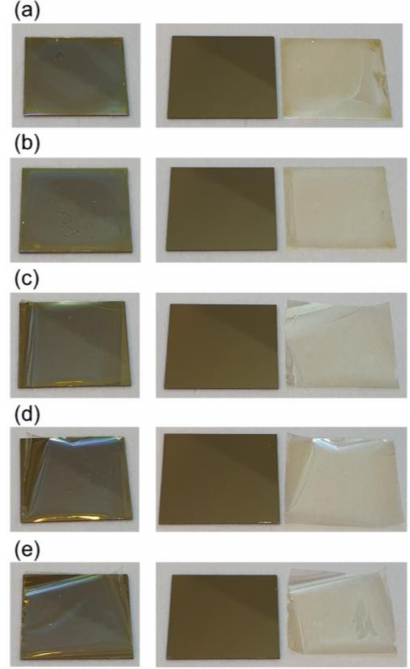
Figure 5. Image of the lift-o ff PI film according to the PI spin-coating conditions: ( a ) 2000 rpm, 60 s; ( b )